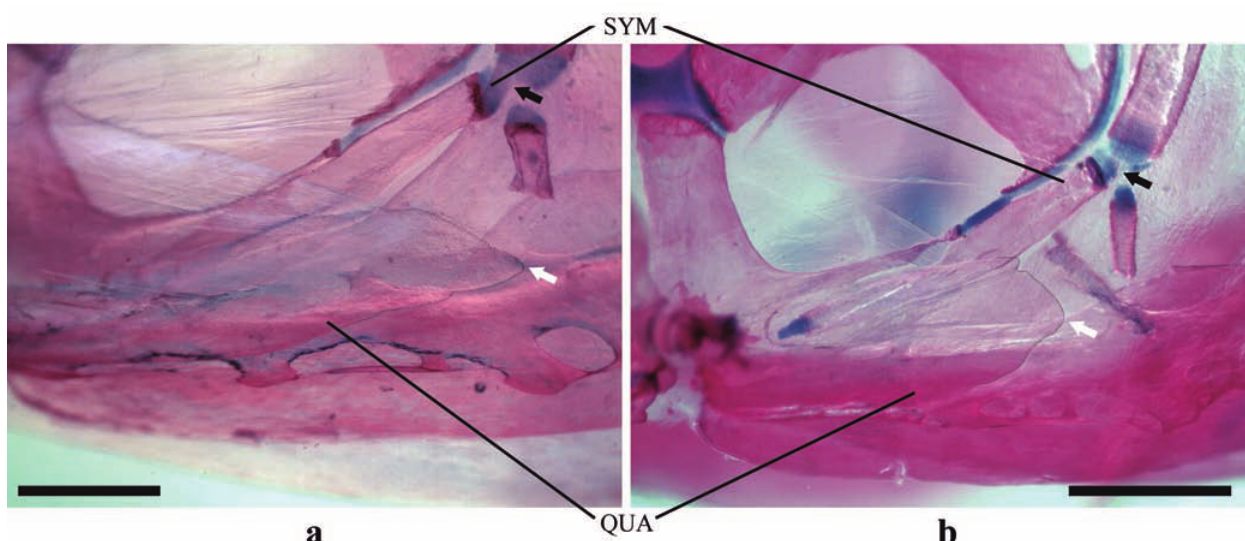
Fig. 6. Detail of suspensorium of ( a ) Chrysobrycon yoliae , CI-FML 5882, paratype male, 44.8 mm SL, and ( b ) Chrysobrycon eliasi , paratype male, AI 287, 39.9 mm SL, comparing the posterior extent of ventral process of quadrate (QUA, white arrows) with respect to the vertical through posterior margin of symplectic (SYM, black arrows). Anterior to left. Scale bar = 1